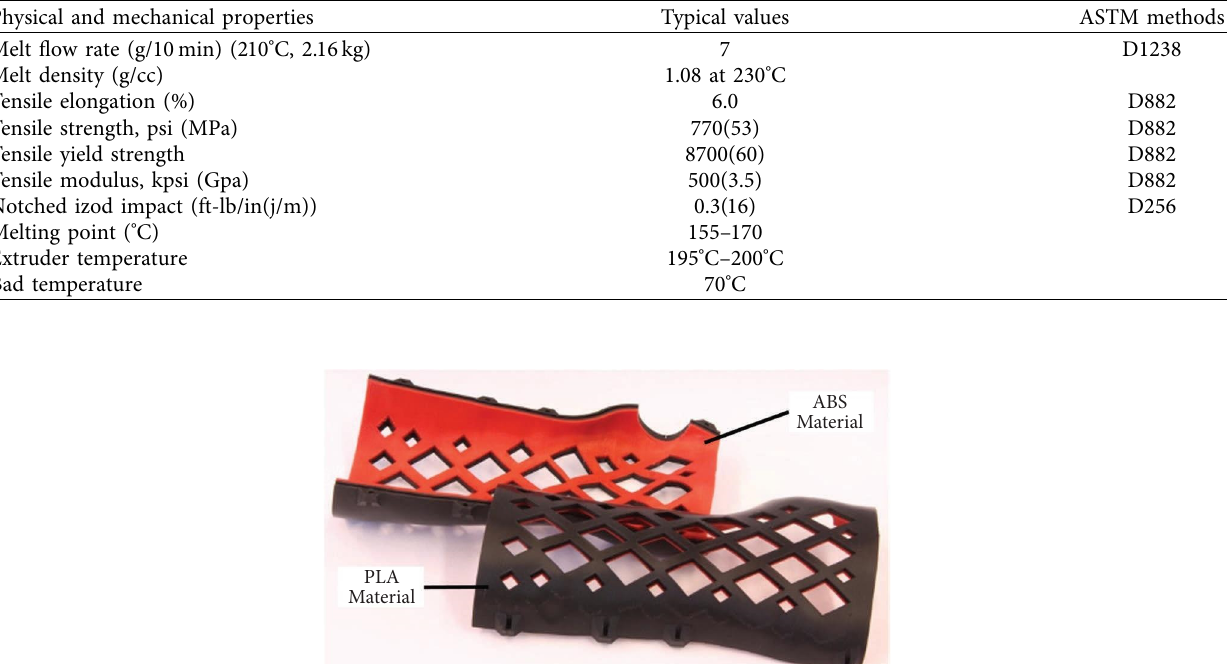
Table 5: Properties of PLA.